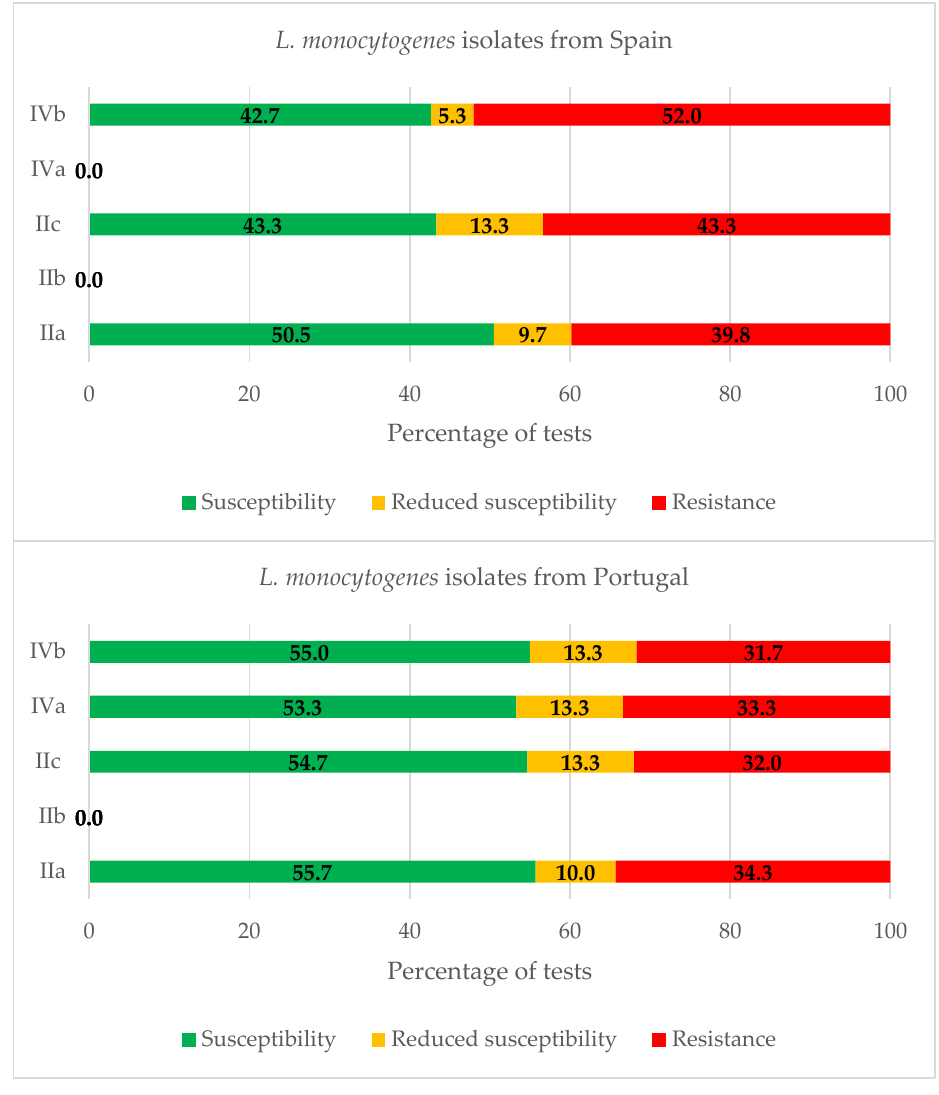
Figure 4. Percentages of strains of Listeria monocytogenes which are either resistant, have reduced susceptibility, or are susceptible in each serogroup.